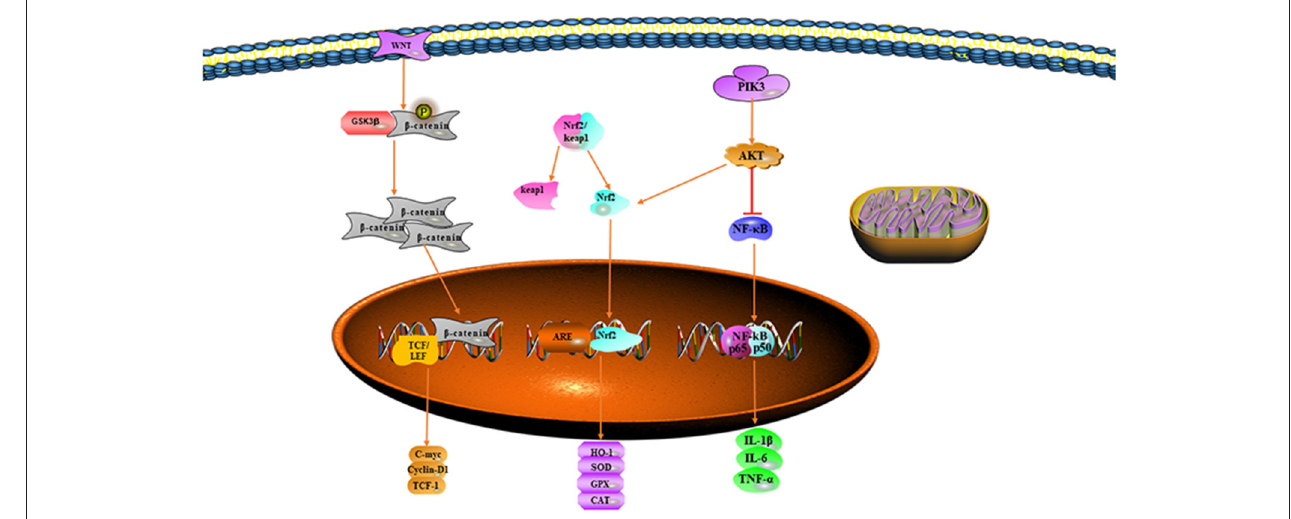
FIGURE 1 | Signaling pathways mitigating oxidative